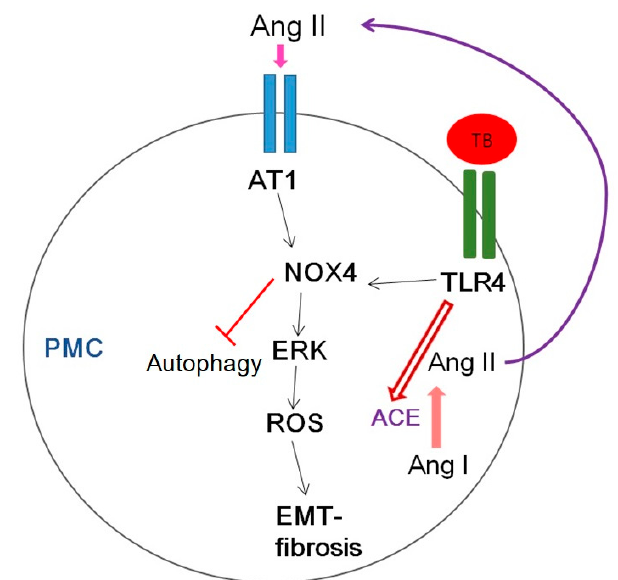
Figure 10. Schematic diagram of the signaling pathway relevant to HKMT-induced pleural fibrosis in pleural mesothelial cells (PMCs). AT1, Angiotensin II receptor type1; ROS, reactive oxygen species; EMT, epithelial mesenchymal transition; TB, tuberculosis; TLR4, Toll like receptor 4; ACE, angiotensin converting enzyme.